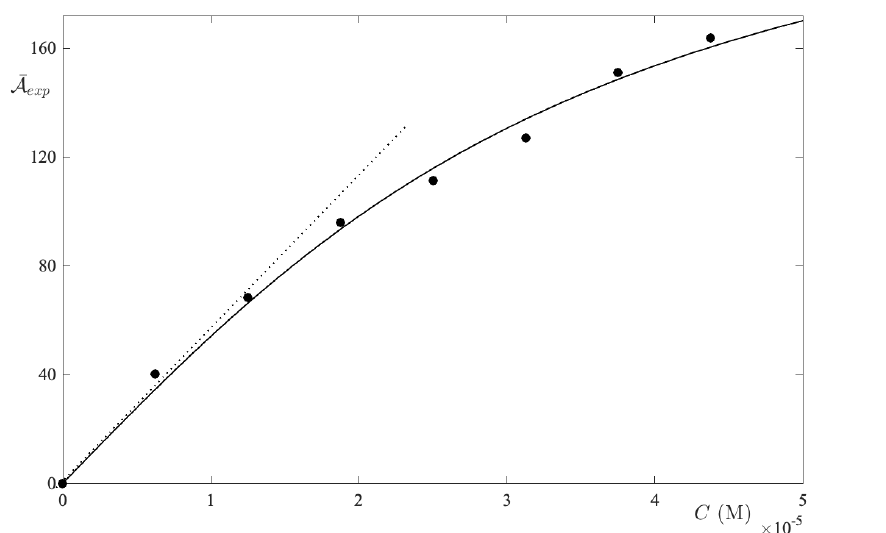
Figure 8. The integral absorbance vs. the MB concentration in UPW. The limiting slope determines the absorption coefficient of the monomer form. The curve is a guide for the eyes.